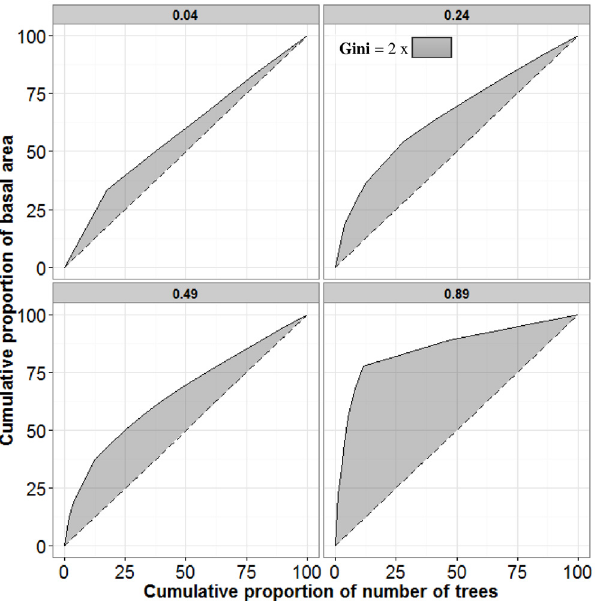
Fig 1. Lorenz curve to calculate the Gini coefficient index for 4 different inventory plots. The Gini coefficient values are presented in the title of each facet. Trees are ranked according to their size (in our case individual tree basal area) in a descending order (according to Valbuena et al . 2013 [49]). The dashed lines represent the line of absolute